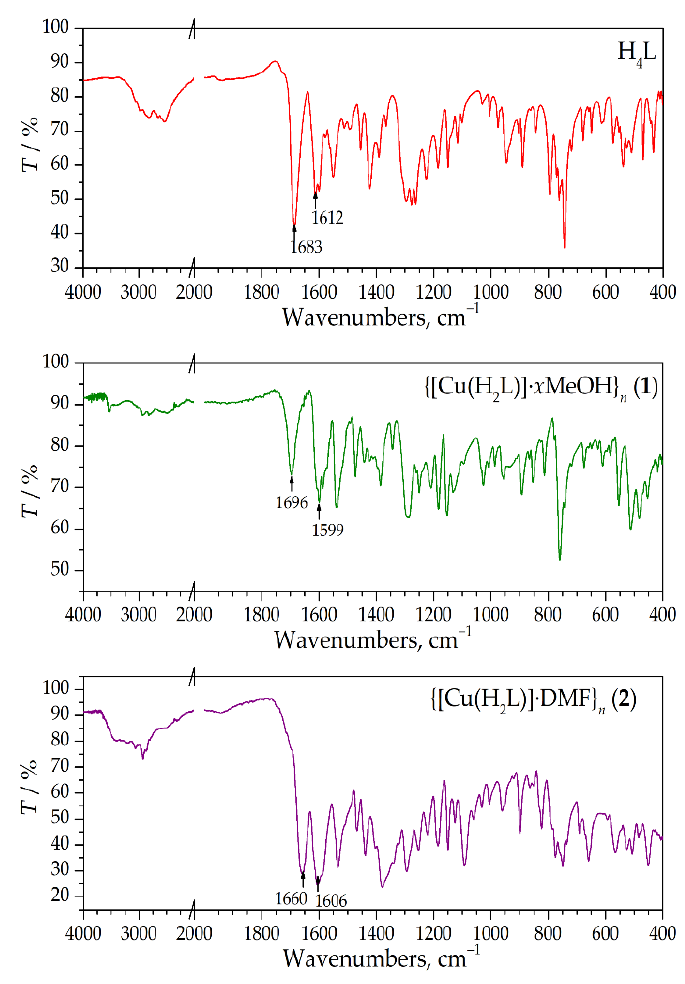
Figure 1. IR spectra of the ligand H 4 L and compounds 1 and 2 .